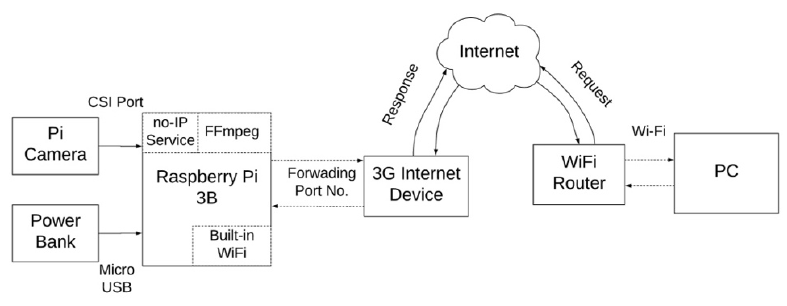
Figure 1. Schematic overview of proposed solution’s system architecture implementation.